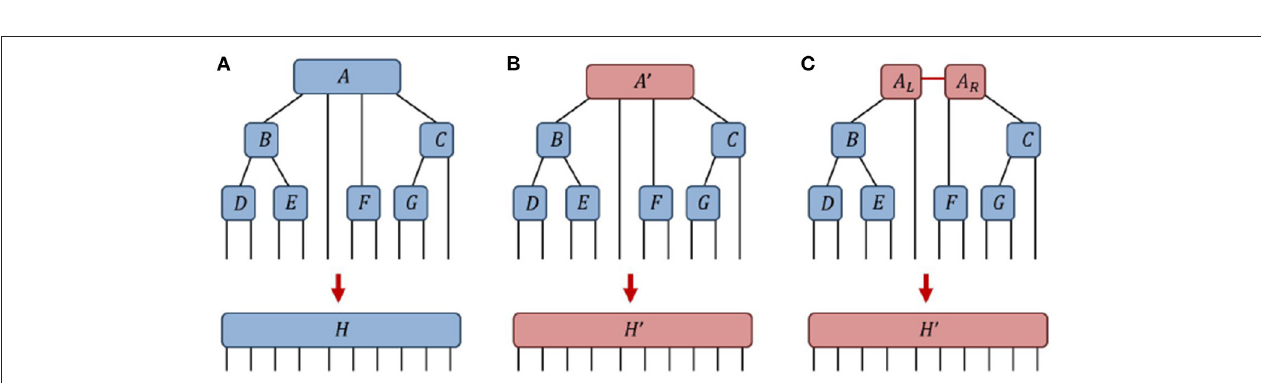
FIGURE 12 | (A) A network of 7 tensors { A , B , C , D , E , F , G } contracts to give a tensor H . (B) After replacing a single tensor A → A ′ the network contracts to a different tensor H ′ . (C) The tensor A ′ is decomposed into a pair of tensors A L and A R , leaving the final tensor H ′ unchanged.